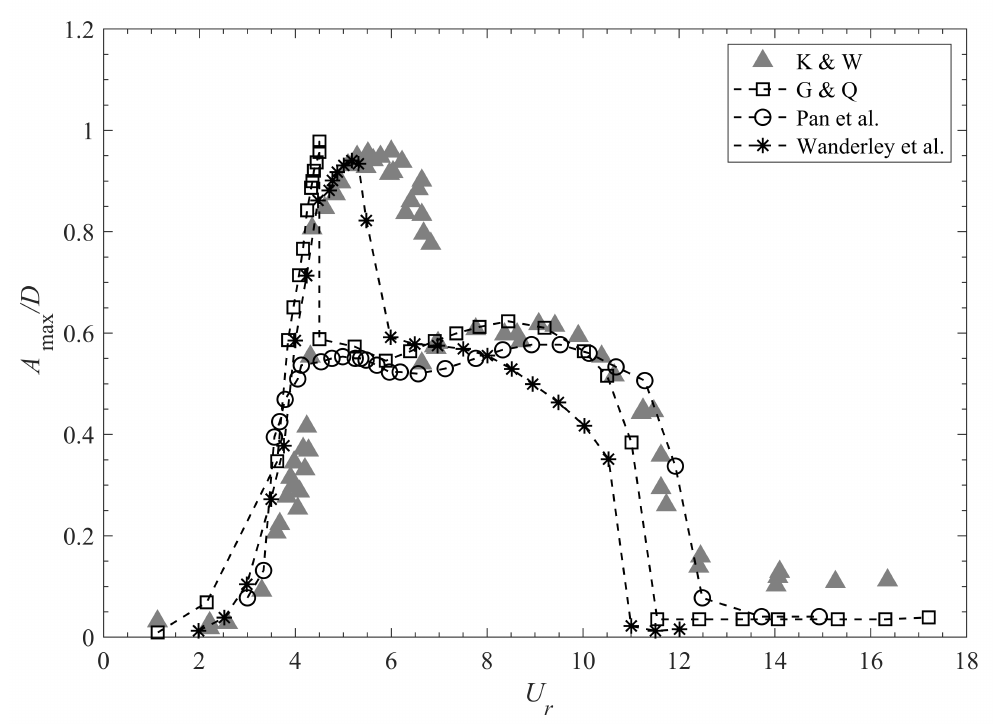
Figure 9. The variation with the reduced velocity U r of the normalized maximum structural ampli- tude ( A max / D ) of FIV consisting of an elastically-mounted circular cylinder of diameter D with a mass ratio of 2.4 and mass-damping ratio of 0.013. The results of three RANS modelling studies are compared with some experimental data reported by Khalak and Williamson [159] (K&W). The RANS modelling studies shown here were conducted by Guilmineau and Queutey [160] (G&Q), Pan et al. [161], and Wanderley et al.